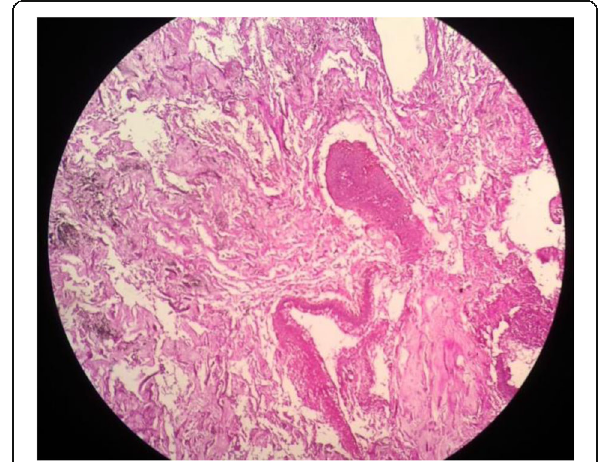
Fig. 5 Haematoxylin and eosin staining of the specimen shows lung tissue with arthrocotic pigments and necrotic areas with angioinvasion